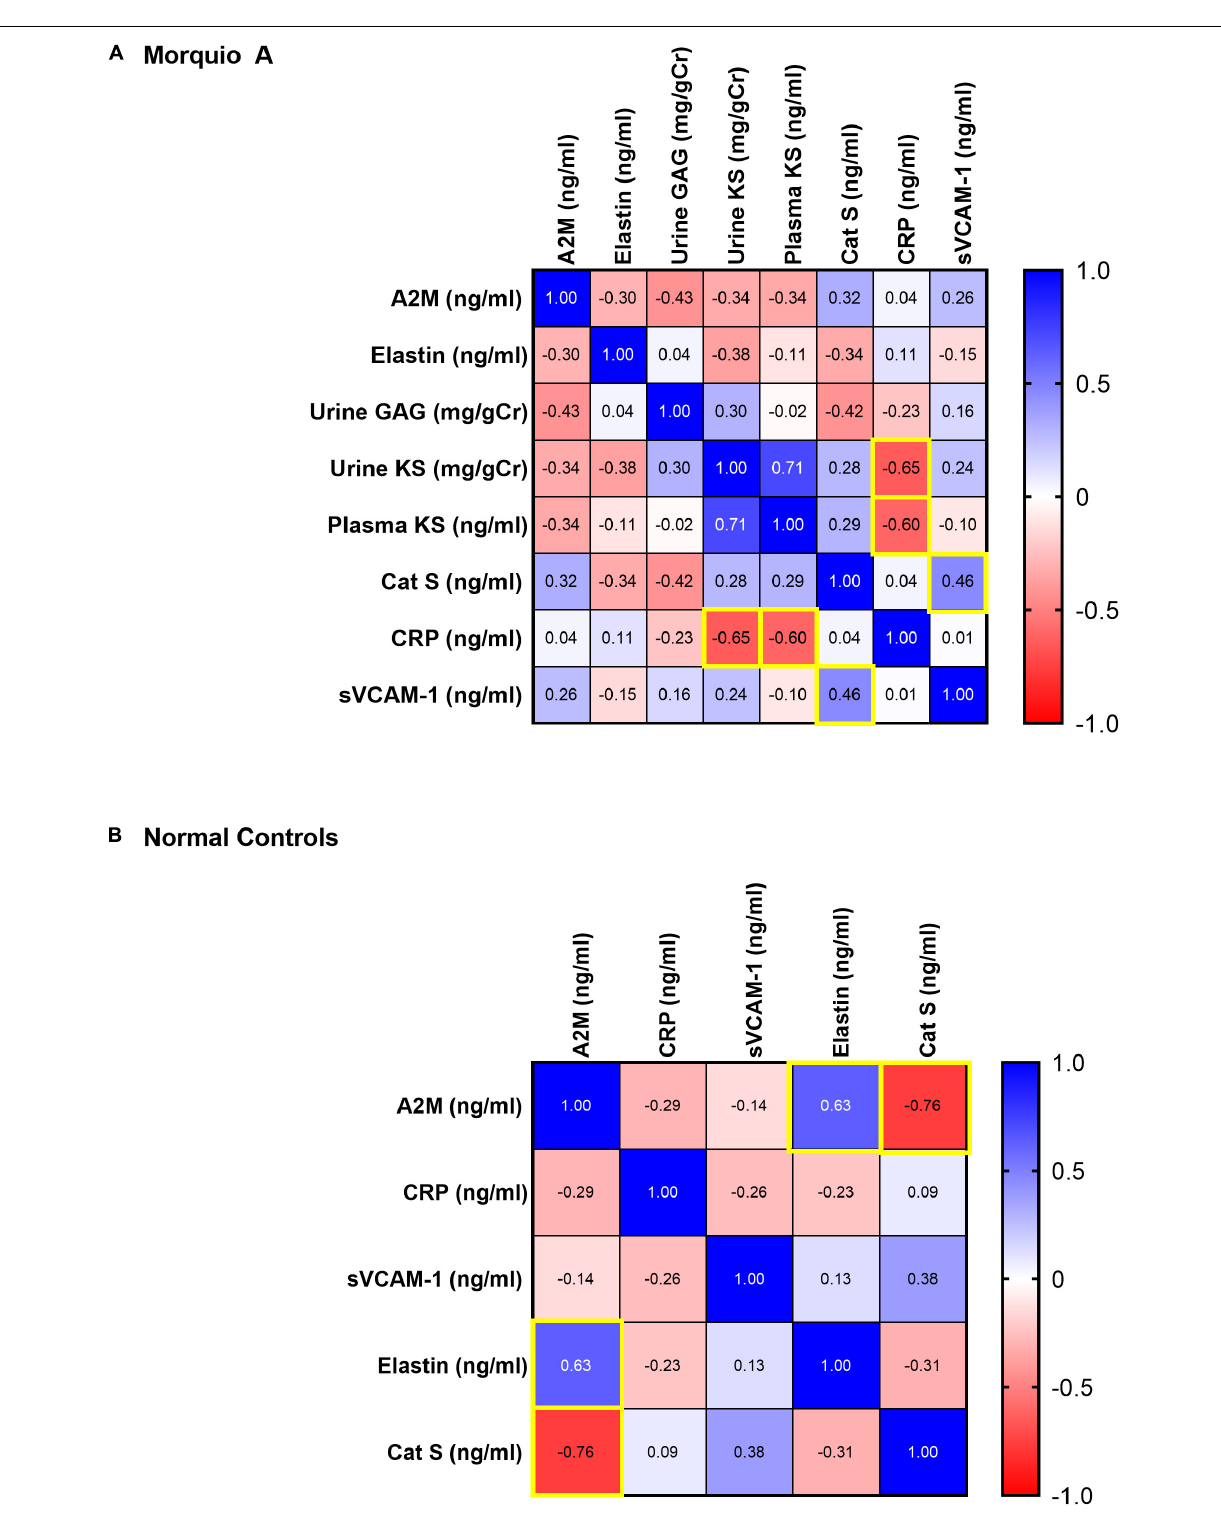
Frontiers in Cardiovascular Medicine |